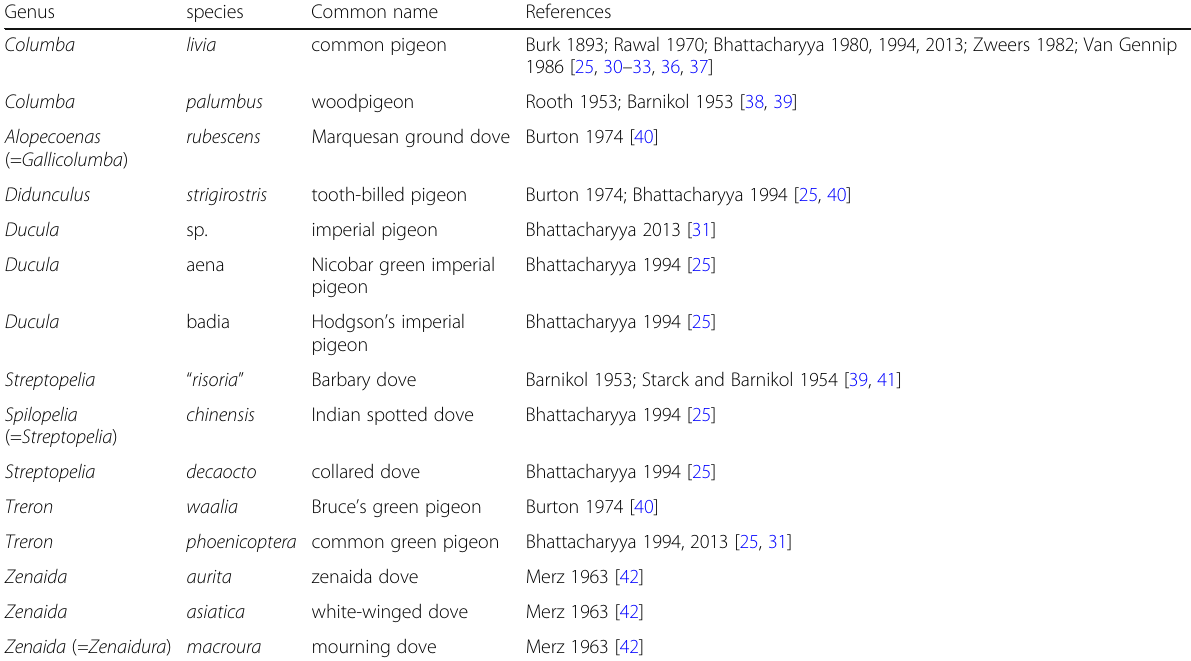
Table 1 Previous descriptions of jaw, neck, and throat muscles in columbiform birds